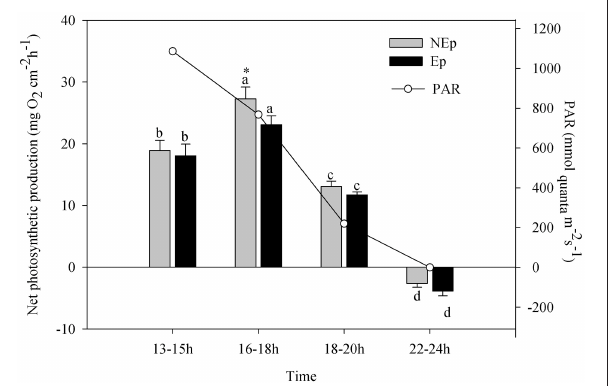
FIGURE 1 | Net photosynthetic rates of Posidonia oceanica along the day (local time, UTC+1). Different letters indicate significant differences with time of the day ( p < 0.05 ); * indicates significant differences between shoots with (Ep) and without (NEp)